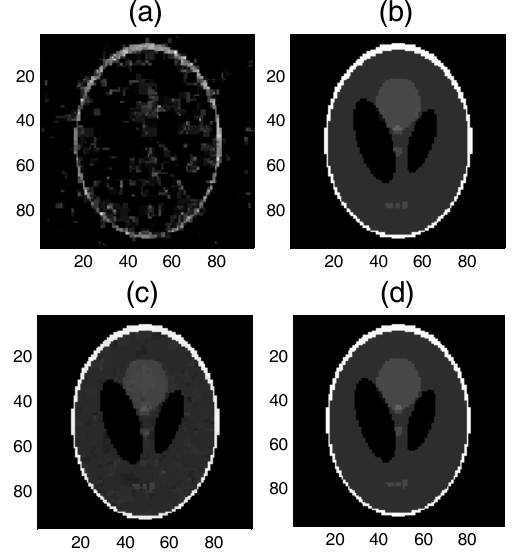
Figure 10. The recovery effects of the proposed SAITA- L p ( p ∈ { 1/2, 2/3 } ) and the corresponding L p ( p ∈ { 1/2, 2/3 } ) algorithm for the M / N = 0.140, mSNR = 40 dB Shepp-Logan image. ( a ) L 1/2 , RSNR = 3.5436 dB; ( b ) SAITA- L p algorithm ( p = 1/2), RSNR = 43.7016 dB; ( c ) L 2/3 , RSNR = 27.2450 dB; and ( d ) SAITA- L p algorithm ( p = 2/3), RSNR = 44.9549 dB.